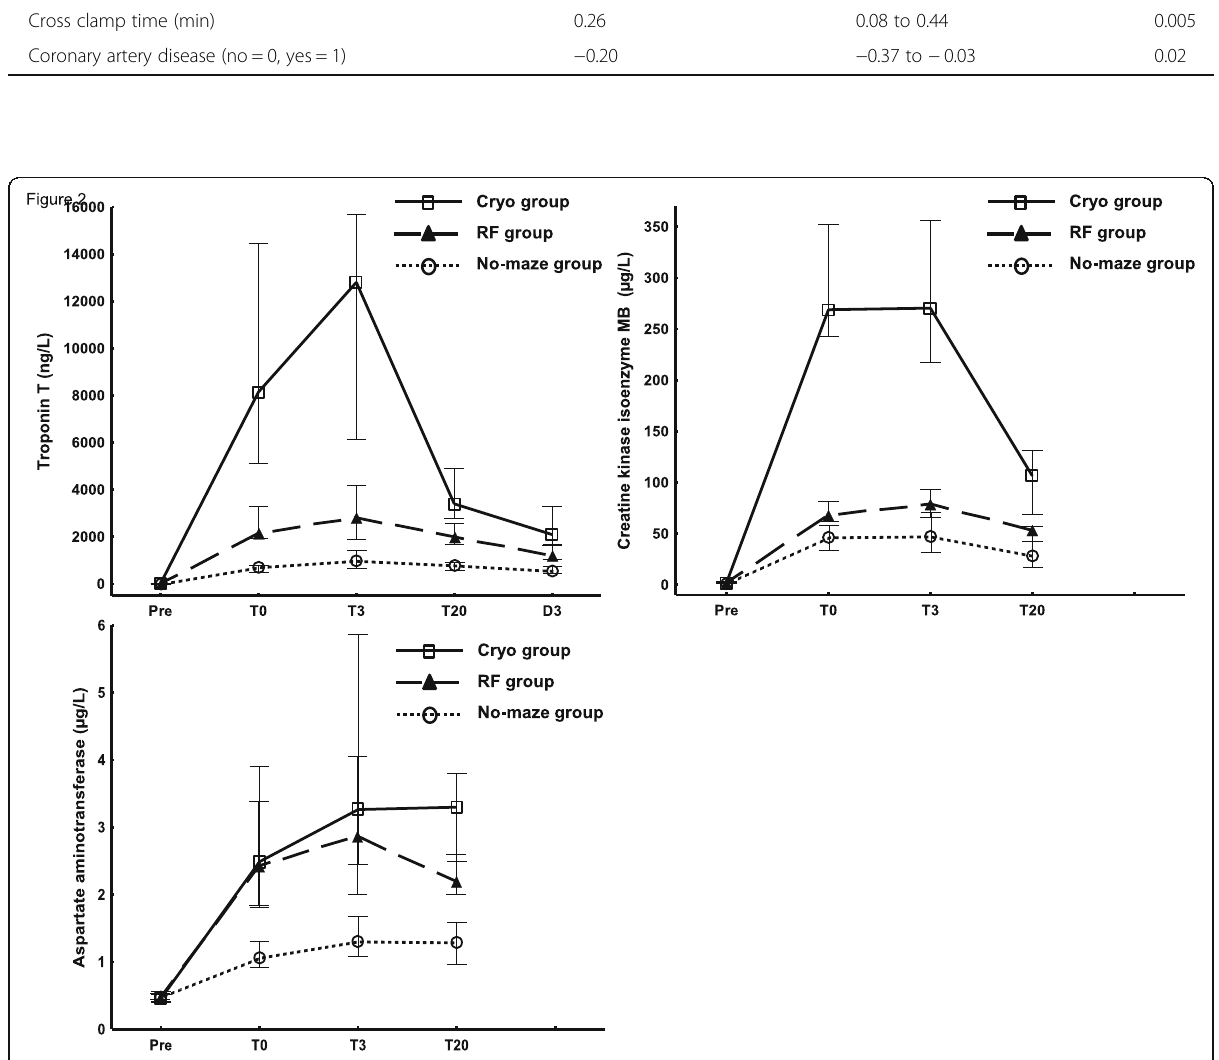
Fig. 2 The detected fractions of aspartate aminotransferase (ASAT), troponin T (Tn-T), alanine aminotransferase (ALAT), and creatine kinase isoenzyme MB (CK-MB) after heating to 37 °C, 56 °C, 65 °C, and 80 °C for 3 min expressed as percentages of the values from non-heated samples (median [25th to 75th percentile]) in 10